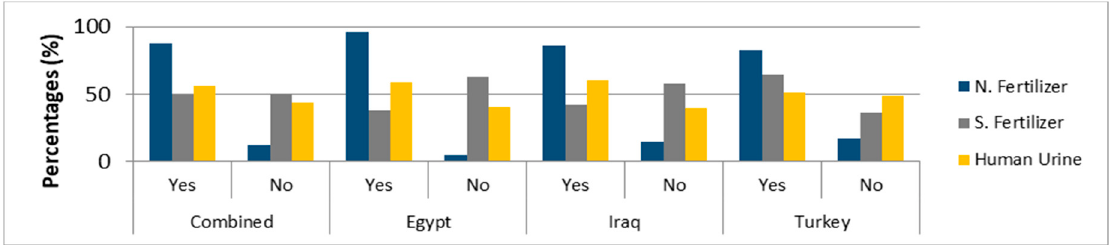
Figure 5. Acceptance of natural fertilizer, synthetic fertilizer, and source separated human urine.